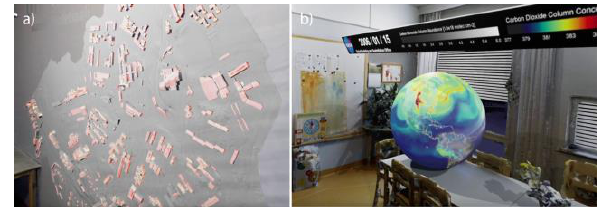
Figure 5. Geo-information assets visualized in VR environment. (a) The urban area model (mounted on the wall of one of the rooms) and (b) the virtual globe showing an animated texture.